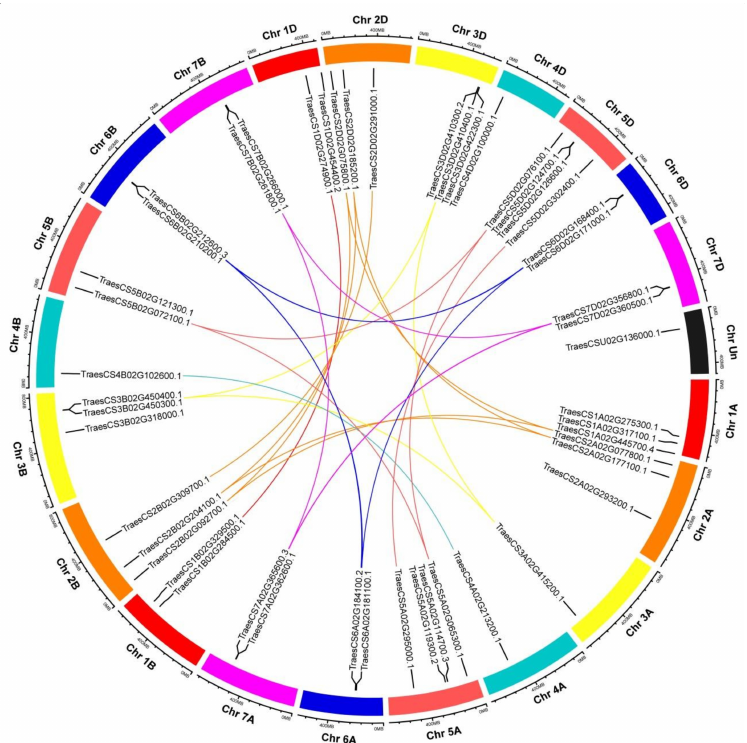
Figure 2. Distribution and duplication of TaHDAC genes in wheat chromosomes. Chromosome columns of the same chromosome group are represented by the same color, with different colors distinguishing different chromosome groups. The bold-colored curve indicates each gene pair subjected to gene duplication, and the short black lines indicate the location of these genes on chromosomes. The graphs of chromosomal location and synteny analysis were established using